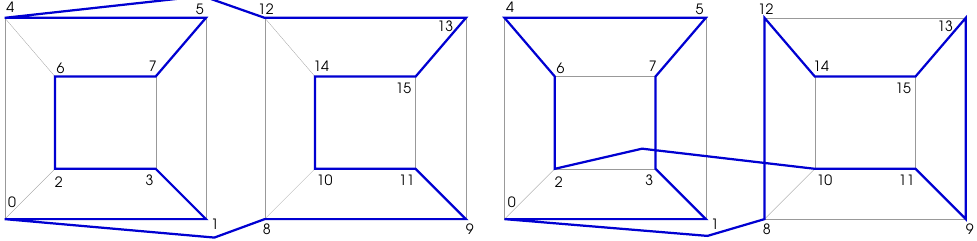
Figure 5. Cycles in the 4-cube with no valid parallel